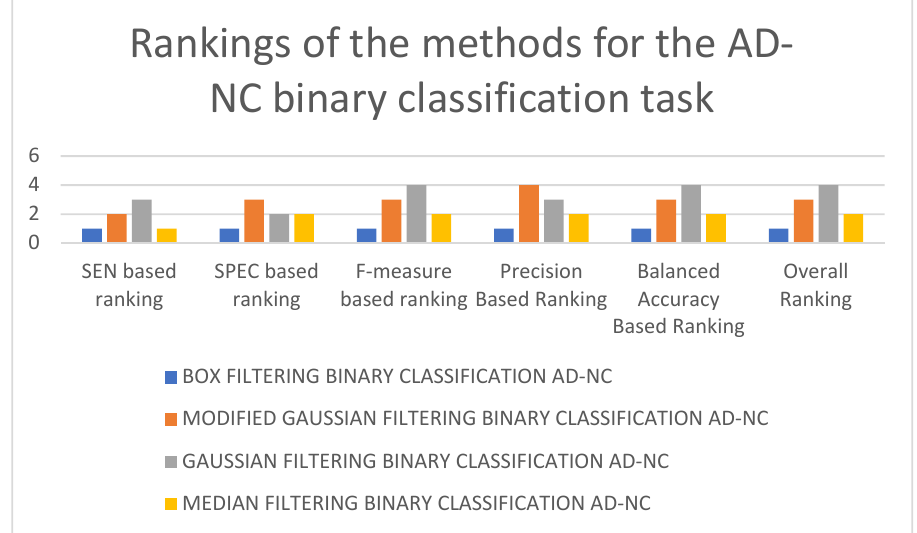
Figure 8. Rankings of different 3D-CNN architectures for the AD-NC binary classification task.